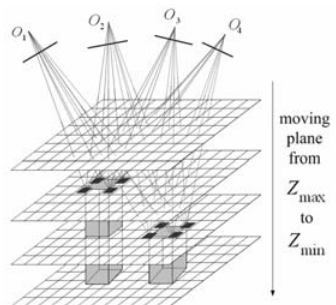
Figure 1. Sketch map of moving Z-Plane constraint